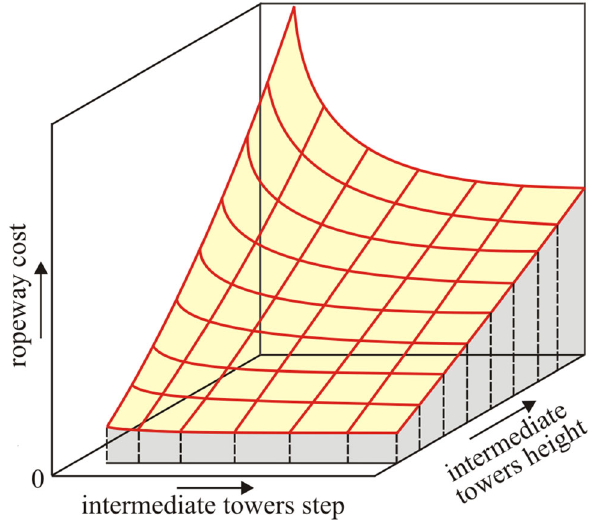
Fig. 1 The influence of the step and height of intermediate towers on the cost of ropeway